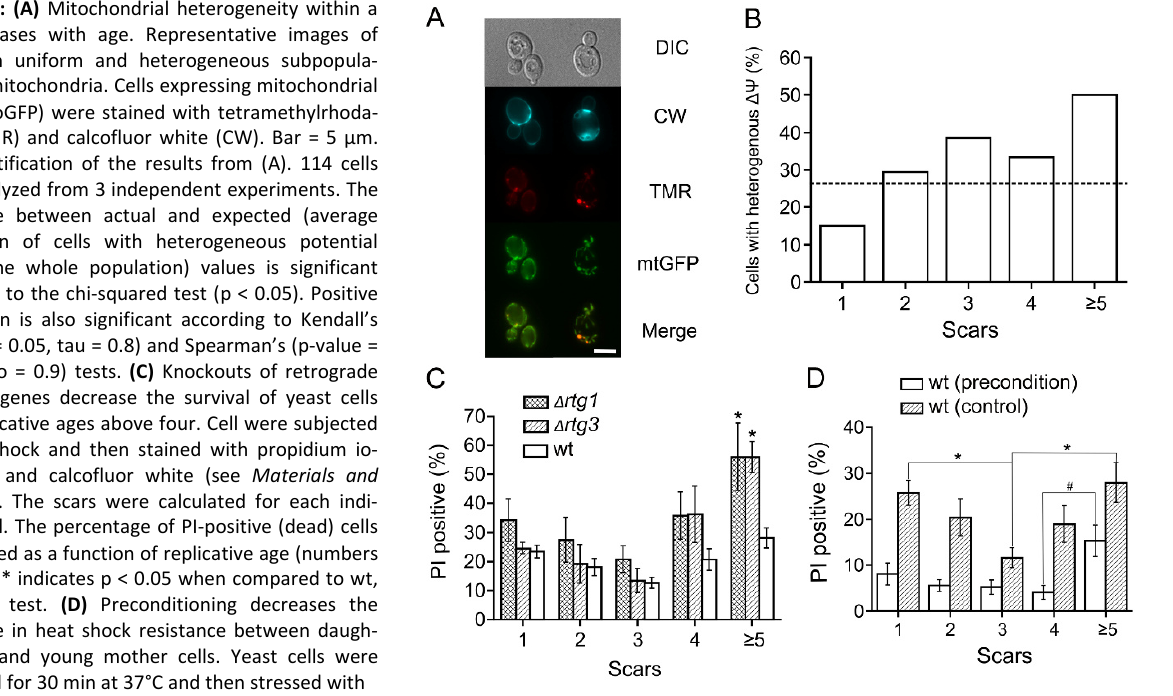
vidual cell. The percentage of PI-positive (dead)